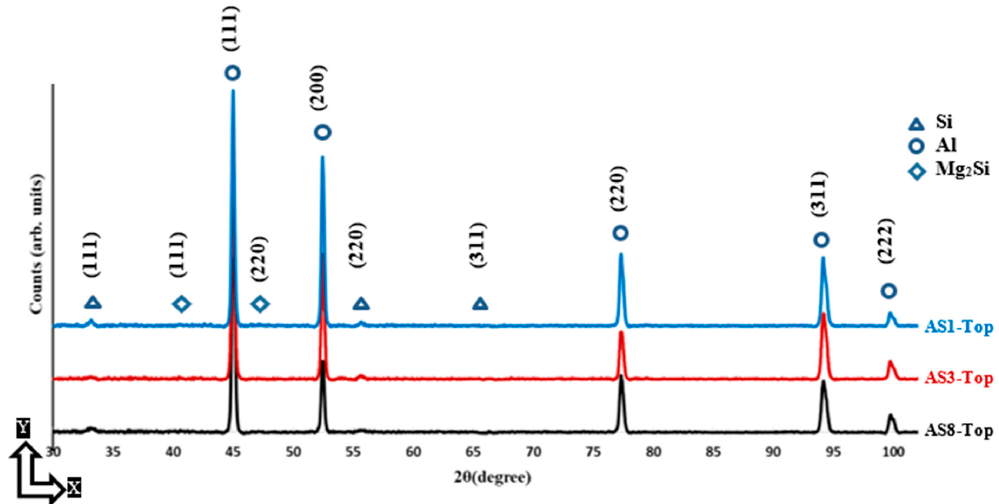
Figure 5. XRD phase pattern measured on the top surface (along the XY plane) of different as-built AlSi10Mg samples. Table 4. Rietveld analysis throughout the top and side surfaces of the as-built AlSi10Mg samples.